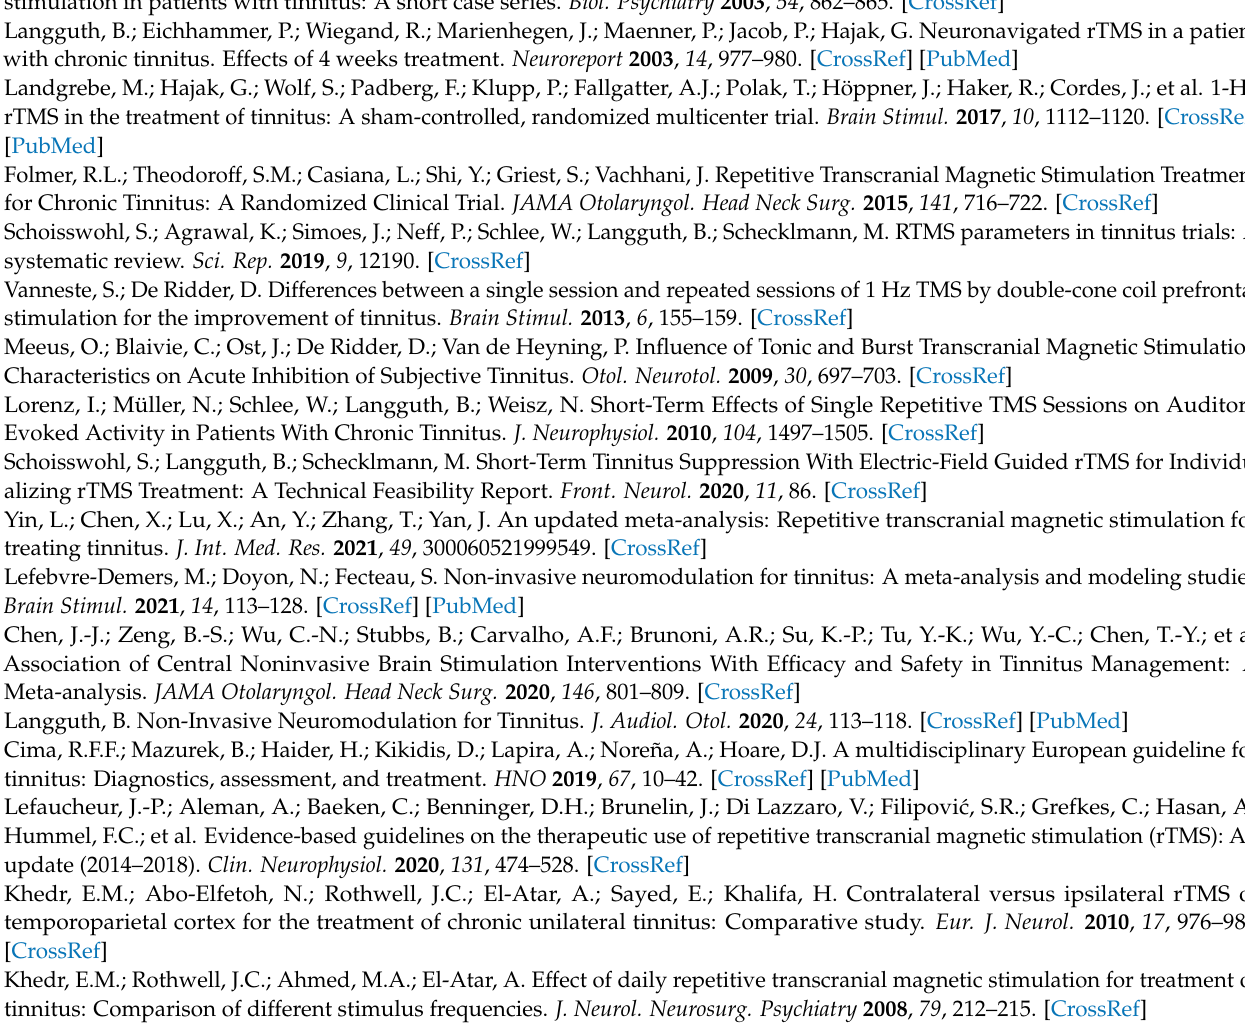
TFI = Tinnitus Functional Index; THI = Tinnitus Handicap Inventory; WHOQOL-BREF domain 1 = World Health Organization Quality of Life—abbreviated—physical health; WHOQOL-BREF domain 2 = World Health Organi- zation Quality of Life—abbreviated—psychological; WHOQOL-BREF domain 3 = World Health Organization Quality of Life—abbreviated—social relationships; VAS = Visual Analog Scale; numDF = degrees of freedom numerator; denDF = degrees of freedom